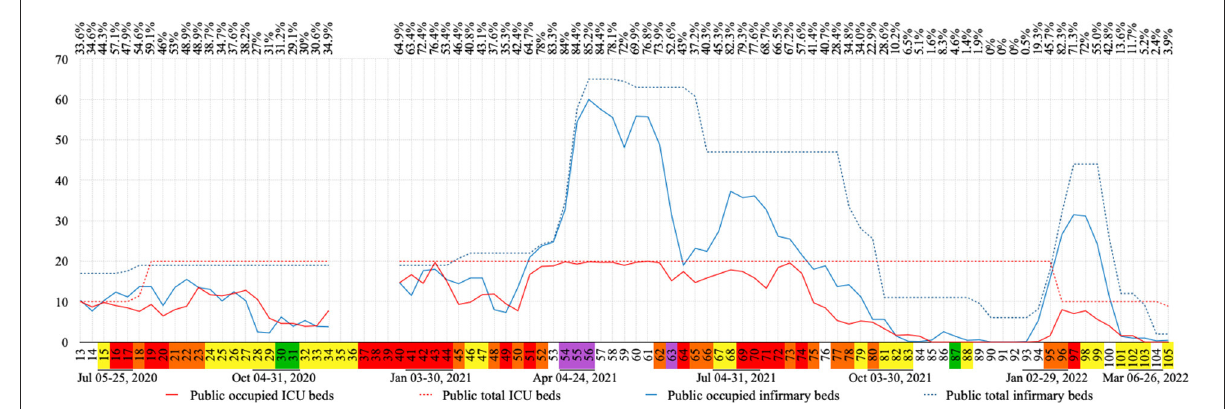
FIGURE6 COVID-19 exclusive public bed occupation per week in absolute numbers. In the line above the graph, is the total occupation percentage for COVID-19 exclusive beds (infirmary and ICU) in public hospitals. Flag colors: Green, very low; yellow, low; orange, moderate; red, high; purple, very high risk. ICU, intensive care unit.